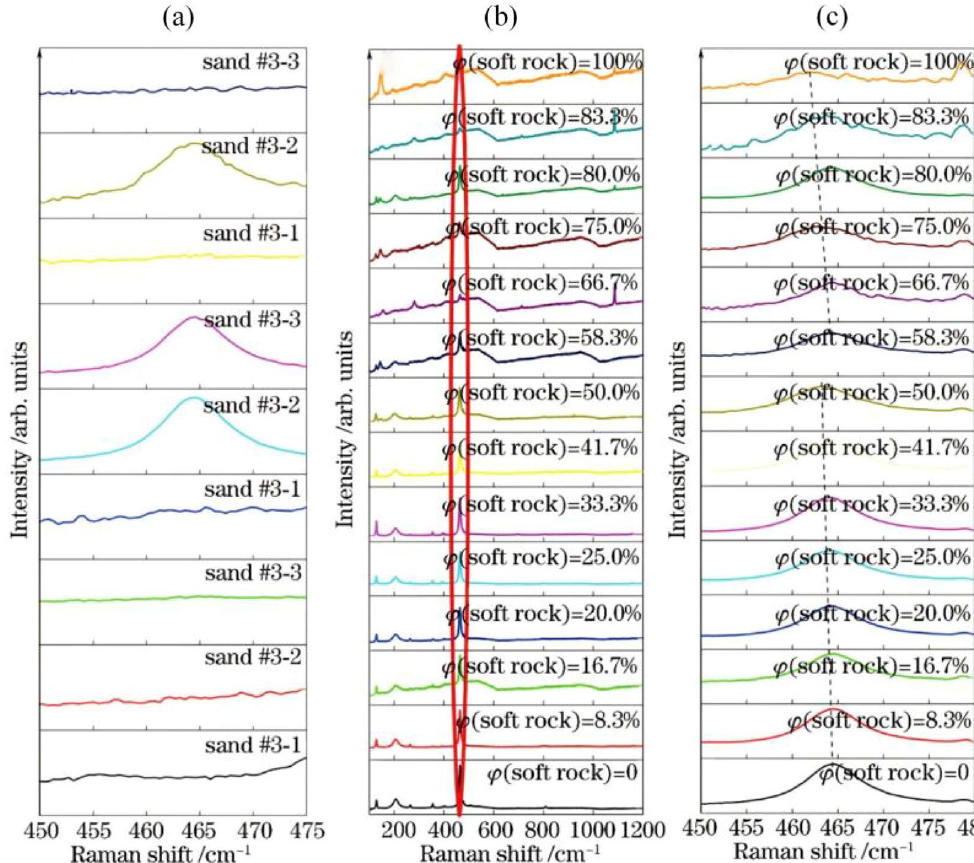
Figure 2. Raman spectra of soft rock, sand and composite soil. ( a ) is a magnified view of nine Raman spectra of sand; ( b ) and ( c ) are the Raman spectra of the soft rock and the composite soil and their magnified images.